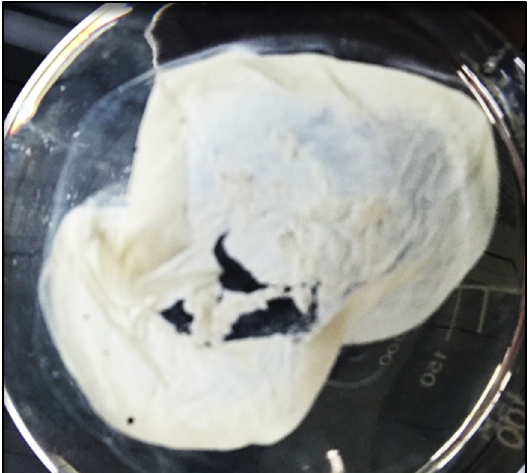
Figure 1. Floating biofilm formed in conical flask. Arthrobacter sp. GN70 was grown in LB broth under static condition for 3 d at 30 °C.